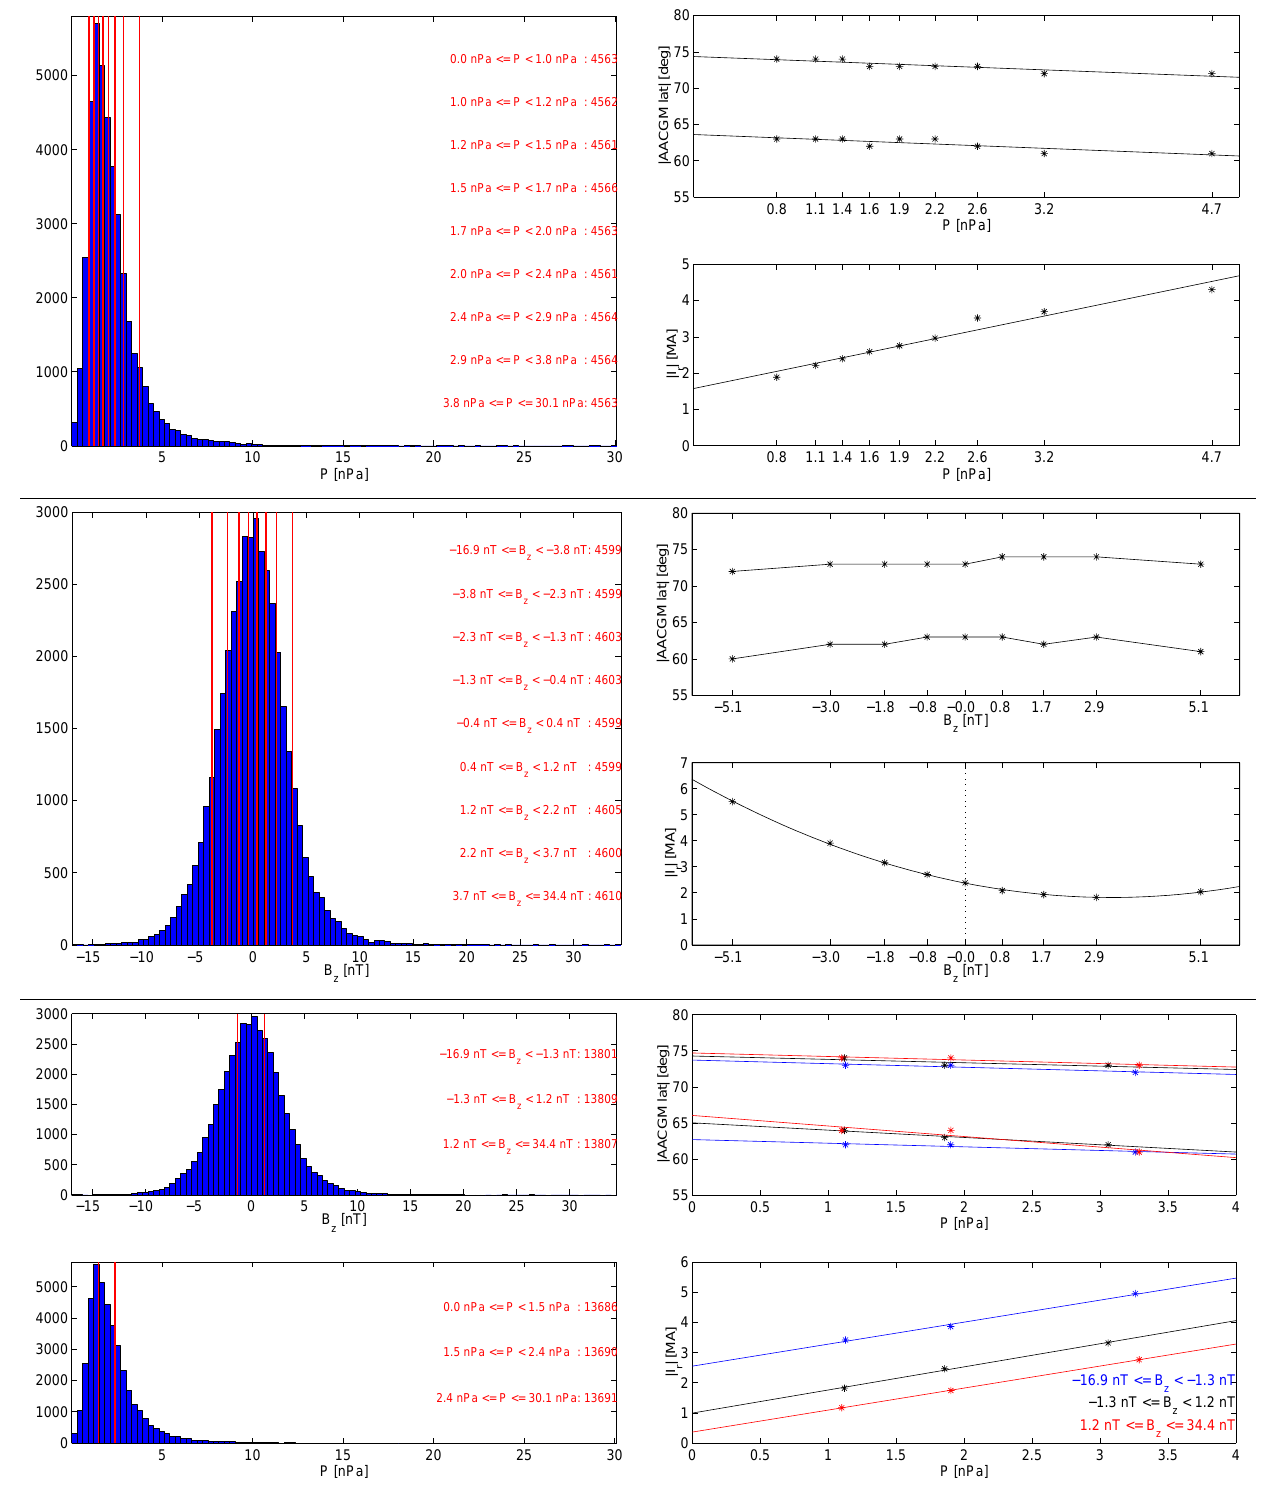
Fig. 9. Left: Distribution of the overflights as a function of the solar wind dynamic pressure P and the z component of the IMF ( B z ). The red lines display the bin boundaries (nine bins for the top and middle panels and three for the bottom panels) and the number of overflights in each bin is written in red. Right: The equatorward and poleward boundaries of the auroral oval and the total field-aligned current as a function of P (top), B z (middle) and P for negative, close to zero and positive B z